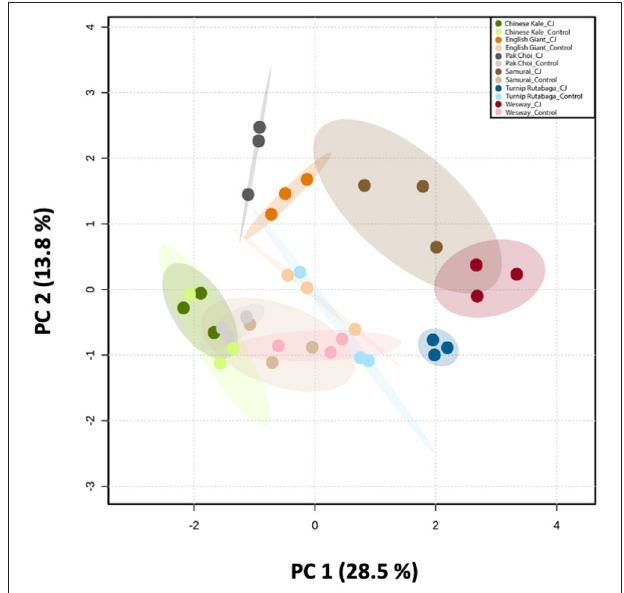
FIGURE 9 | Principal Component Analysis (PCA) of the volatile compounds emitted by six brassica cultivars (i.e., Chinese kale, English Giant, pak choi, Samurai, Wesway, and Turnip Rutabaga) ( n = 3). Score plot visualises the ordination of collected samples according to the first two PCs based on the quantitative values of emitted VOCs from different brassica cultivars with and without CJ-treatment, with the percentage of explained variation in parentheses. The ellipses show 95% confidence